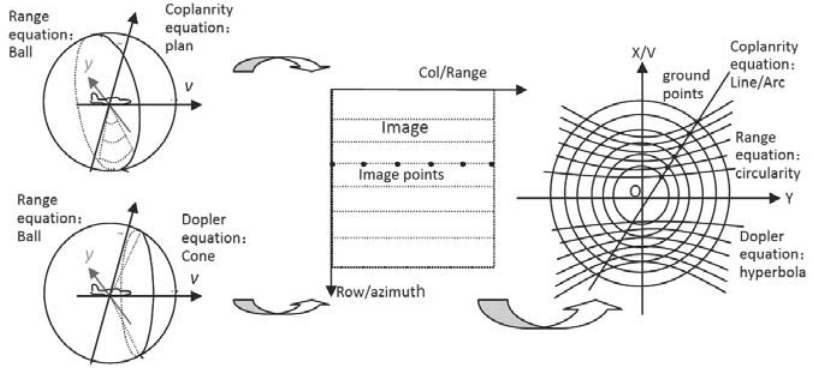
Fig 2 R-D model and R-Cp model positioning